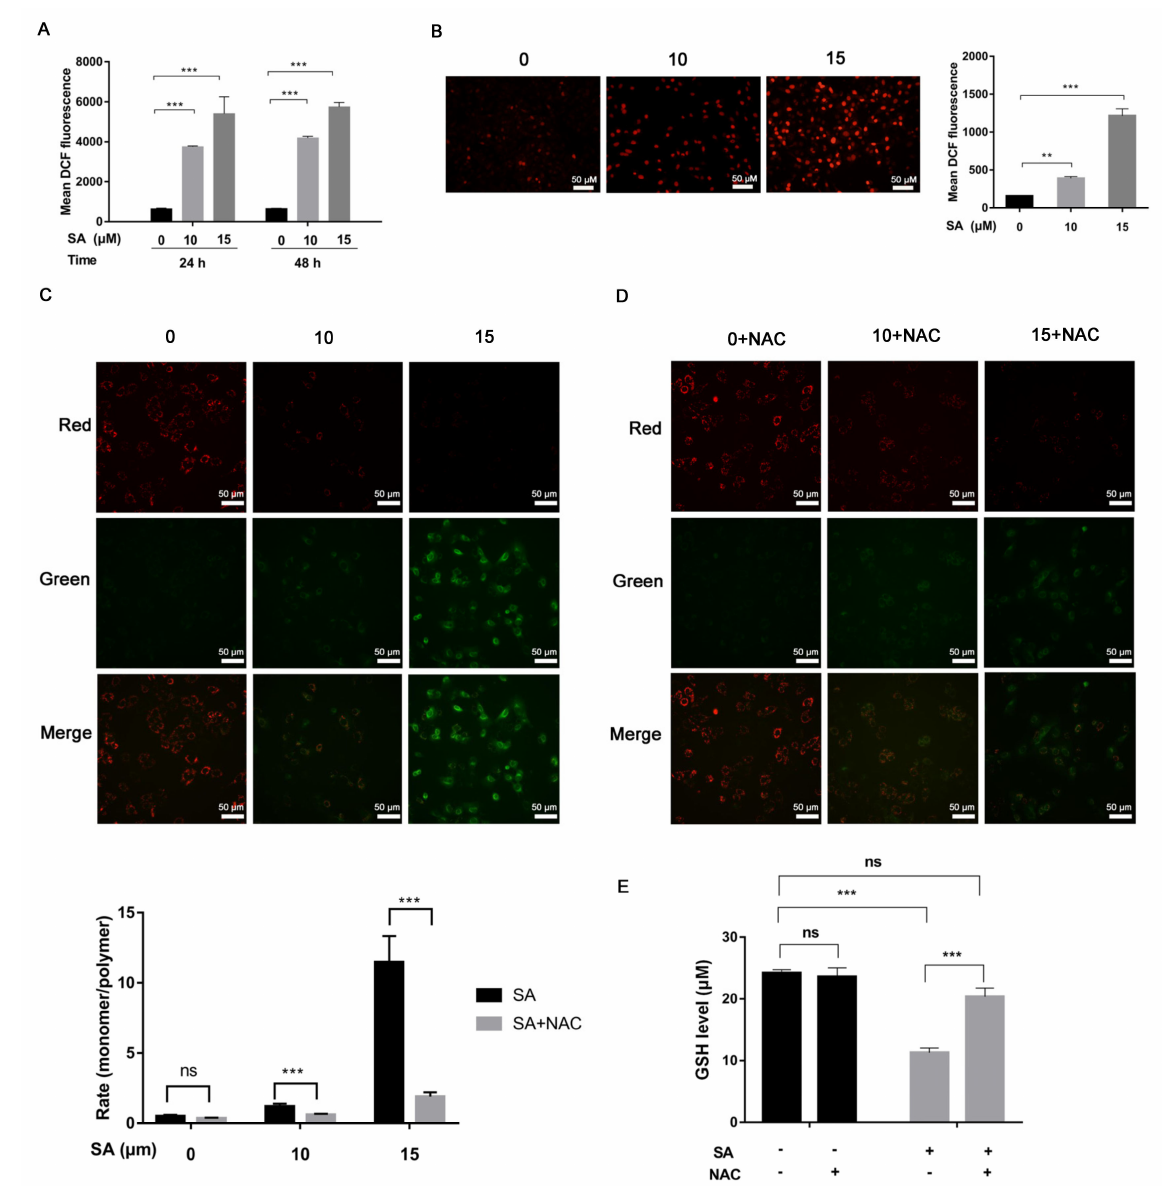
Figure 2. Increased mitochondrial ROS and reduced mitochondrial membrane potential in J82 cells treated with scabertopin. ( A ) Scabertopin induces ROS production in a dose- and time-dependent manner. ( B ) The DHE probe assay shows that superoxide anion is positively correlated with the scabertopin dose. ( C ) The JC-1 assay shows that, after 24 h treatment, scabertopin decreases the mitochondrial membrane potential in J82 cells in a dose-dependent manner. ( C ) The JC-1 assay shows that NAC treatment can restore the mitochondrial membrane potential reduced by 24 h treatment of scabertopin to some extent. ( D ) The DHE probe assay shows that superoxide anion is positively correlated with the scabertopin dose. ( E ) A 24 h treatment with 10 µ M of scabertopin is efficient in depleting GSH through a dose-dependent mechanism in J82 cells, which can be reversed with NAC treatment. A total of 5 µ M of NAC was used in the experiments. Data represent the mean ± standard error of mean (s.e.m.) of the three independent experiments. ** p < 0.01, *** p < 0.001, ns: